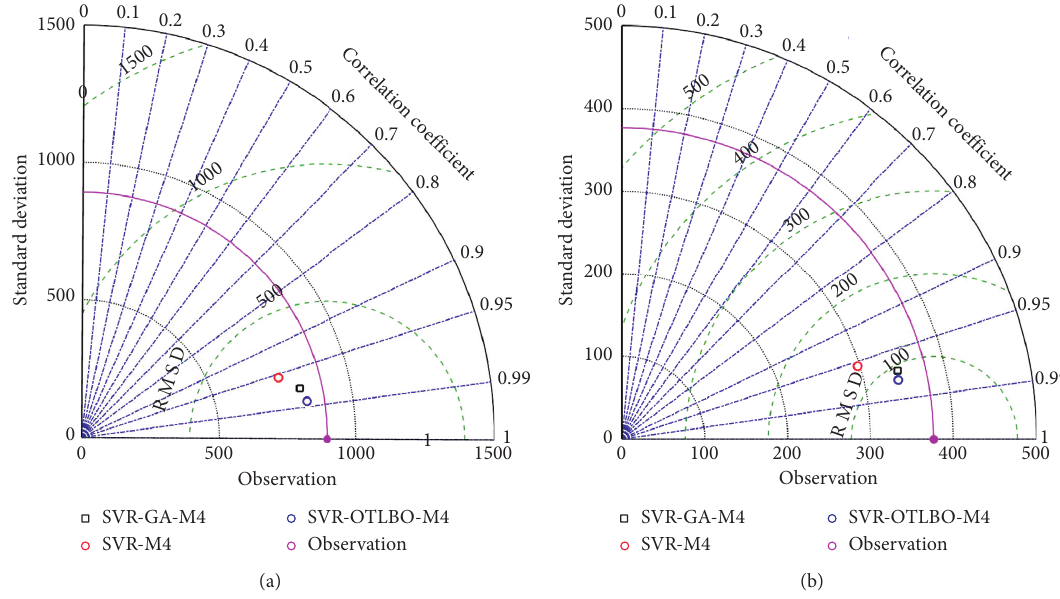
Figure 7: Taylor diagram of the observed and the predicted SSL (mg/lit) for the SVR, SVR-OTLBO, and SVR-GA models in (a) training phase and (b) testing